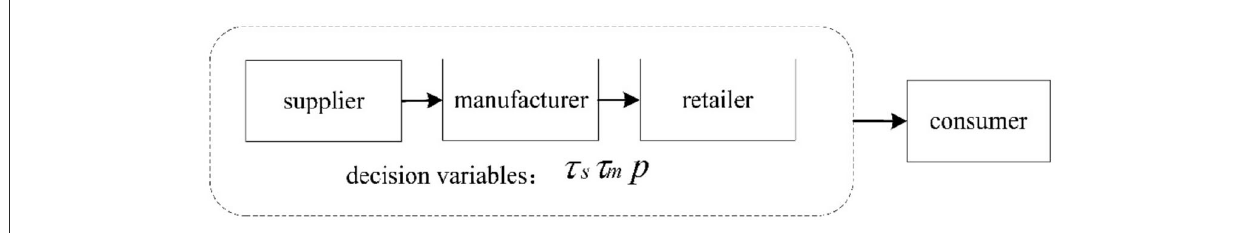
FIGURE3 Supply chain model under the scenario C.